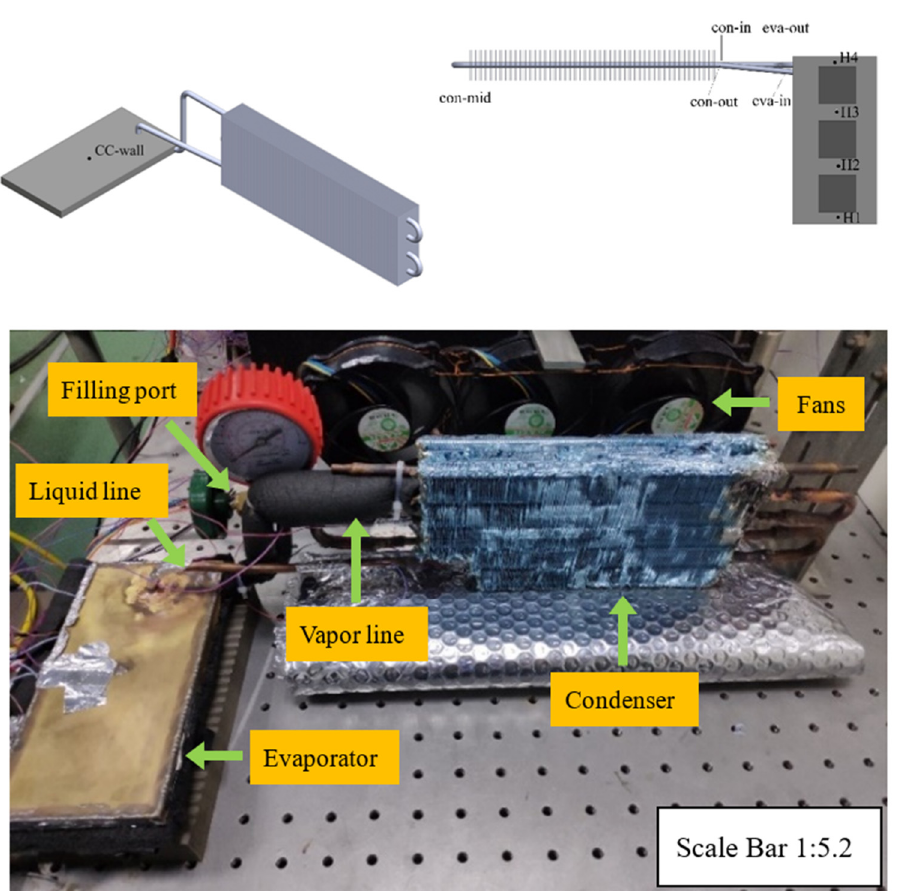
Figure 6. LHP experimental diagram and prototype.